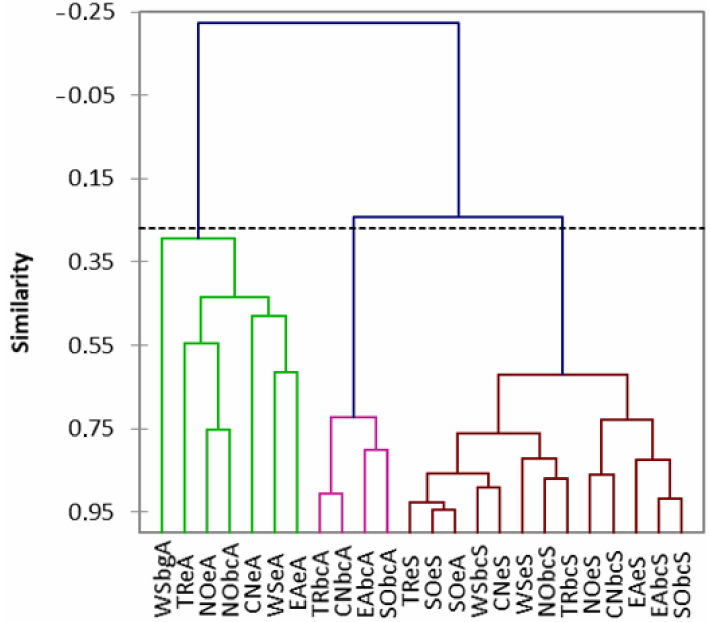
Figure 5. Hierarchical cluster analysis of substrates. Note: WS—administrative area 4 (west suburb); EA—administrative area 6 (east suburb); SO—administrative area 2 (south suburb); NO—administrative area 3 (north suburb); CN—administrative area 1 (central City Zone); TR— administrative area 5 (Trakiya suburb); bc—background; e—experimental; A—autumn;